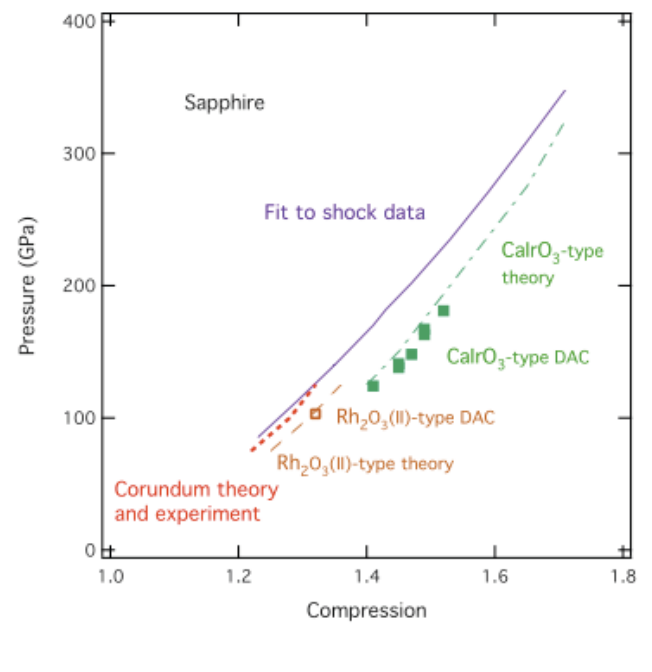
O up to 340 2 3